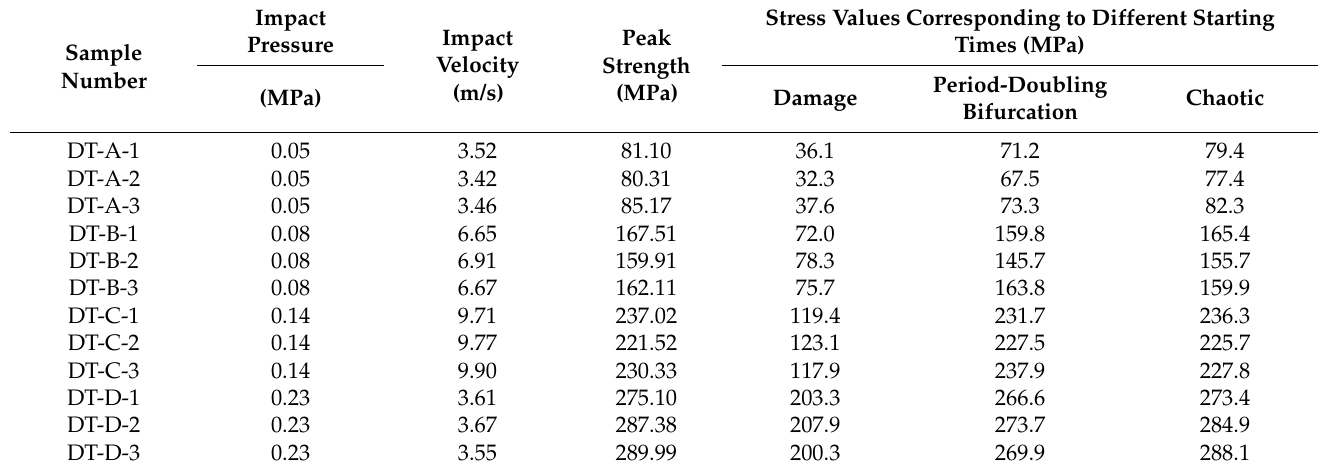
Table 1. The stress value of rock sample damage